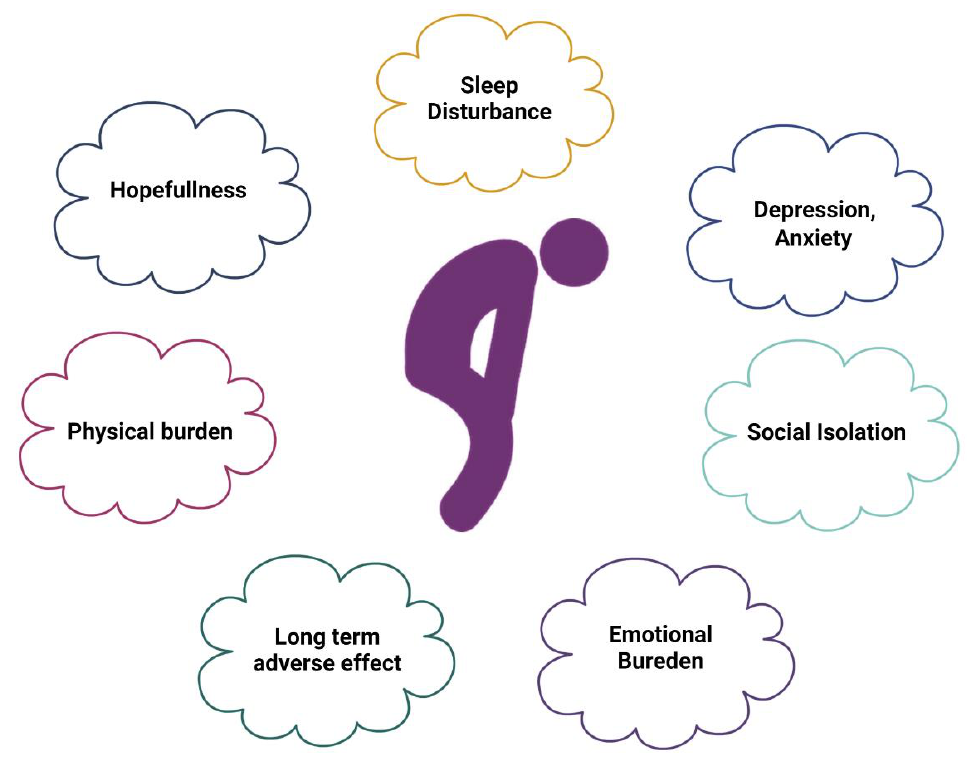
Figure 5. Caregivers’ burden. The caregiving burden progressively increases as the disease ad- vances.